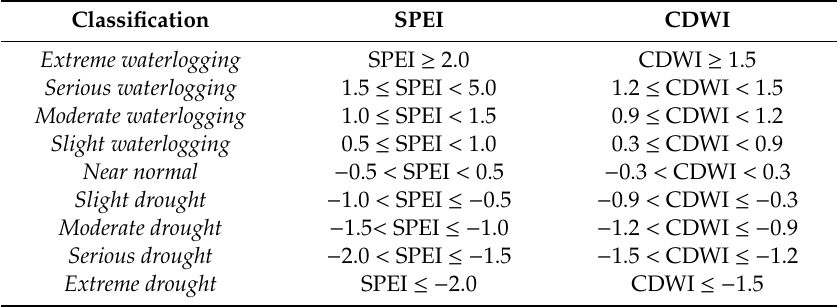
Table 1. Drought and waterlogging classification of the CDWI and standardized precipitation evapotranspiration index